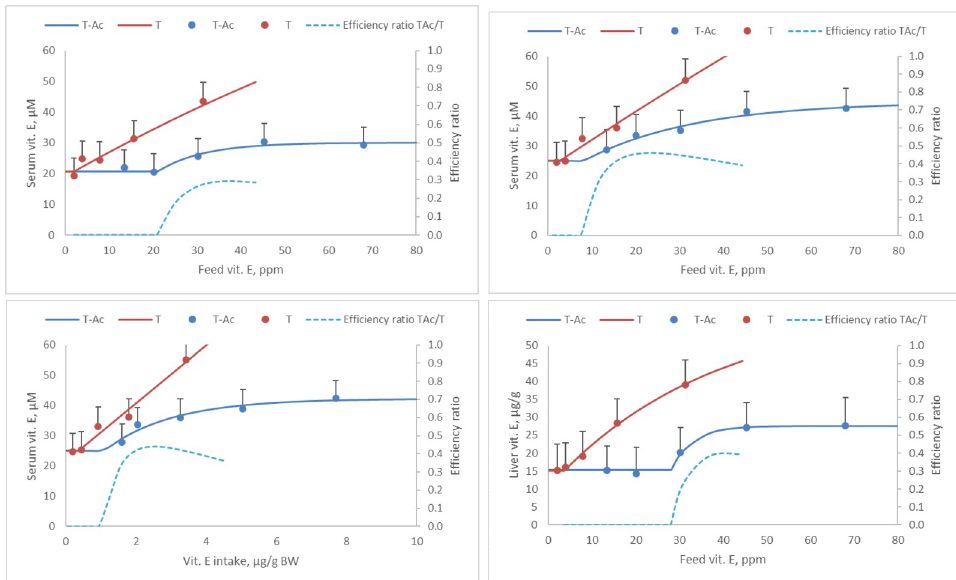
Fig 3. Tissue vitamin E in relation to the dietary level (Fig 3A, 3B, and 3D) or intake (Fig 3C) of tocopherol (T) or tocopheryl-acetate (T-Ac), as well as the efficiency ratio by which each dietary vitamin E source raises serum levels. Graphs show both the modeled results (lines) as well as the LSmeans obtained using ANOVA: A: serum data from group-housed birds fed the test diets for 2 days (2-dg, R 2 = 0.48). B: serum data from individually housed birds fed the test diets for 4 days (4-di, R 2 = 0.54). C: serum data from individually housed birds fed the test diets for 4 days; analysis using actual vitamin E intakes (4-di, R 2 = 0.60). D: liver data from the group-housed birds fed the test diets for 2 days (2-dg, R 2 =